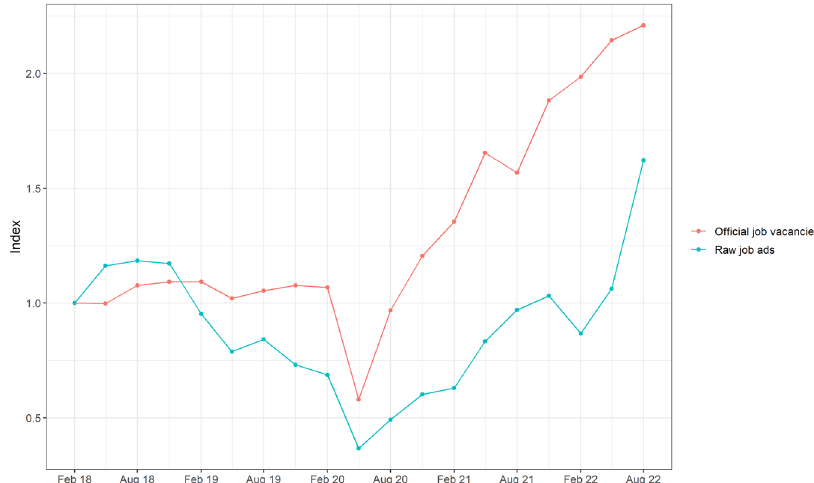
Fig. 1 Australian job vacancies and job postings over time. Indexes of quarterly Australian job vacancies (from the Job Vacancies Survey) and Adzuna Australia job postings between February 2018 and August